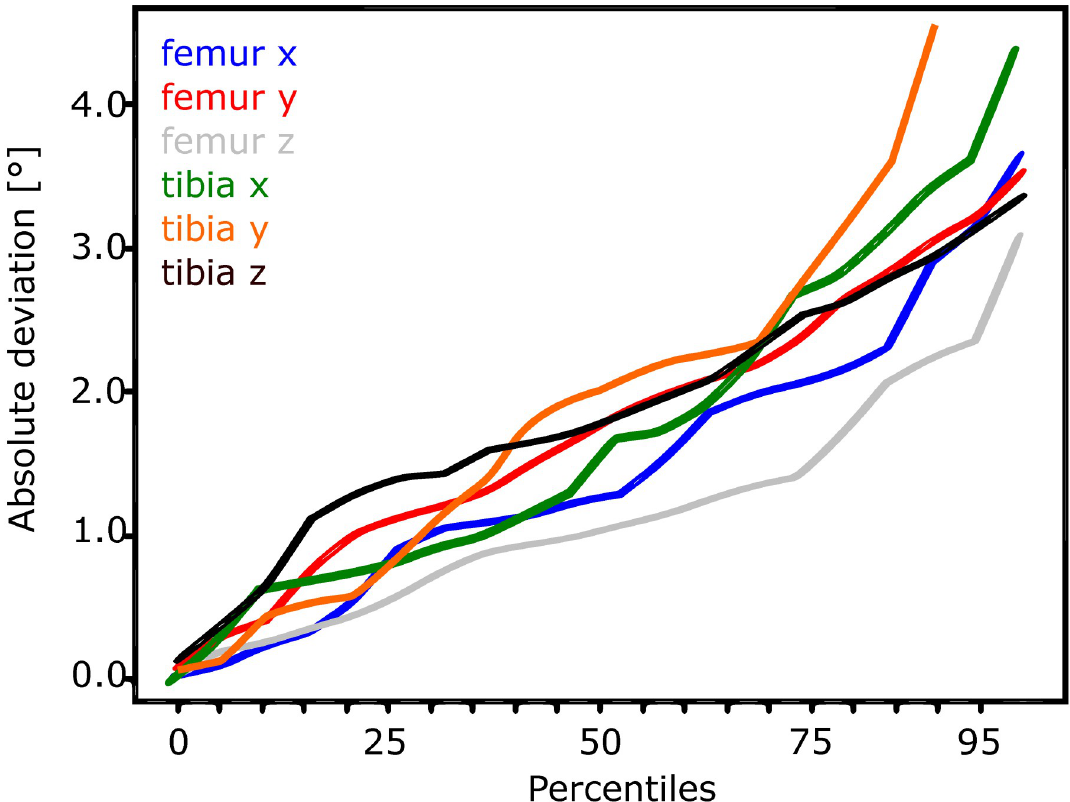
Fig 3. Translation performance for the individualised non-iterative DAMN on the test-set.